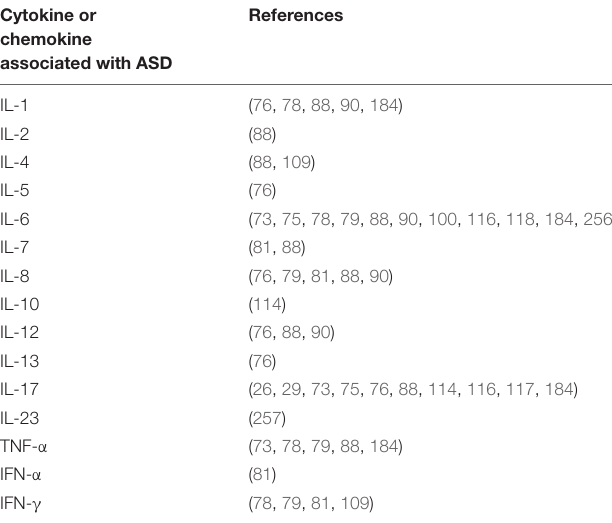
TABLE 1 | Summary of cytokines and chemokines reported to have altered expression in autism spectrum